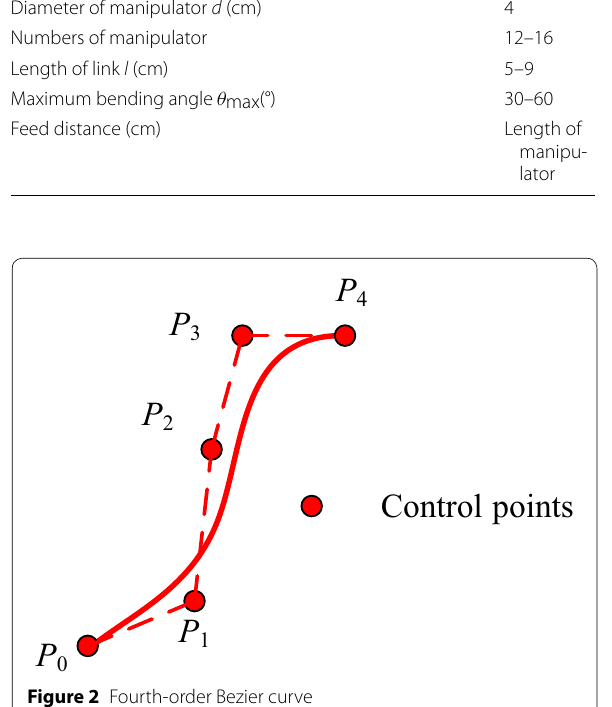
Figure 2 Fourth-order Bezier